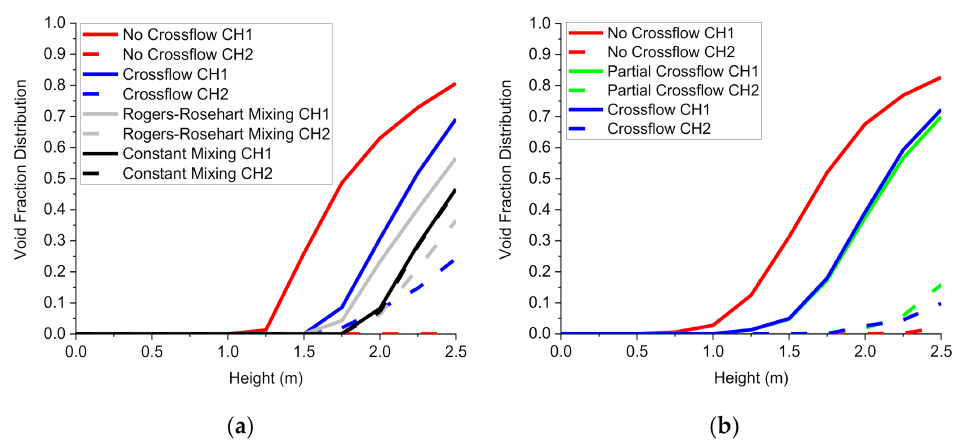
Figure 11. ( a ) CTF void fraction axial distributions; ( b ) FLOCAL void fraction axial